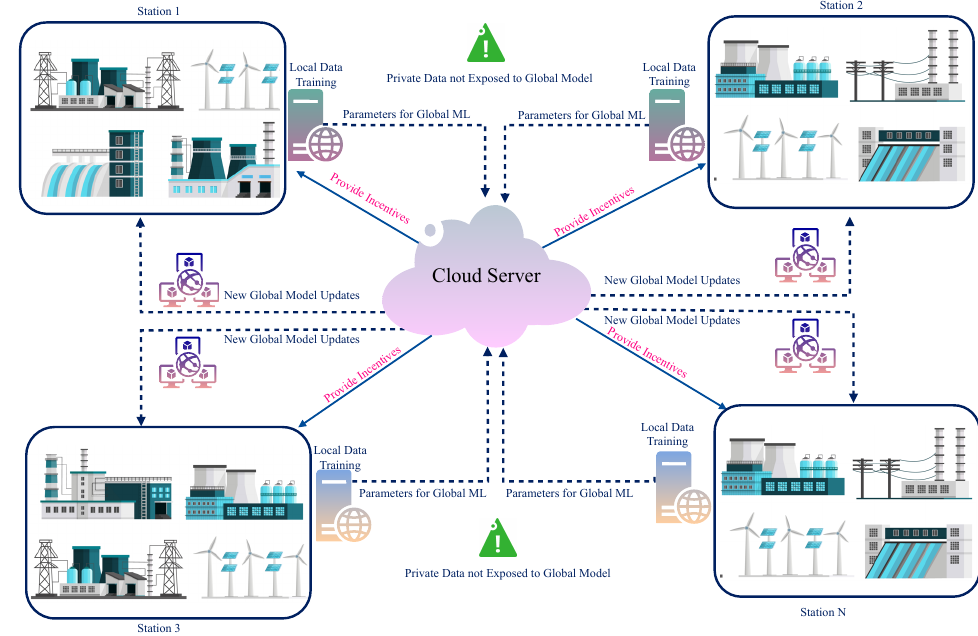
Figure 3. FL Model for providing incentives in